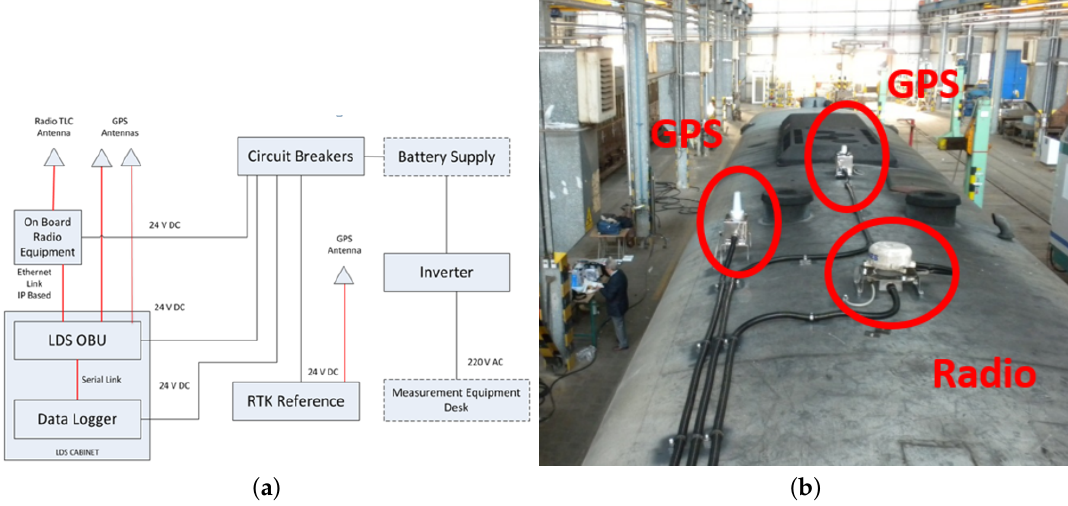
Figure 1. Test trial: ( a ) schematic diagram of the onboard architecture of the measurement system; ( b ) GPS and radio antennas on the train roof.